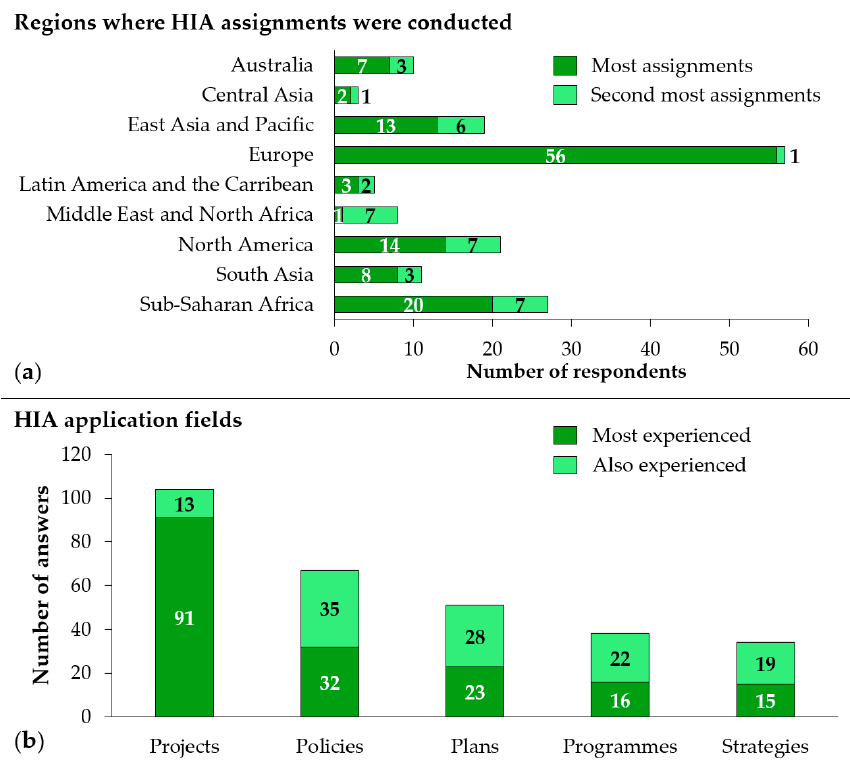
Figure 2. ( a ) Regions where HIA assignments were conducted; and ( b ) fields of HIA application.